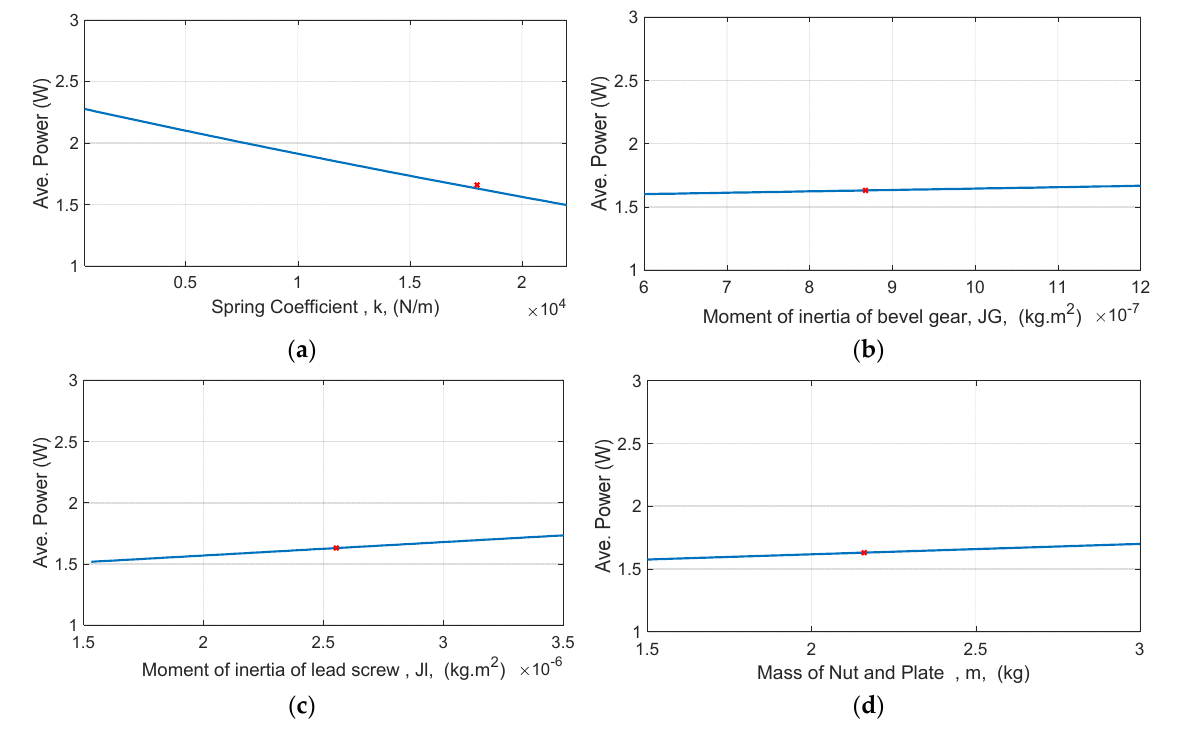
Figure 6. Averaged power when the parameters are varied: ( a ) stiffness coefficient of spring is varied; ( b ) moment of inertia of bevel gear is varied; ( c ) moment of inertia of lead screw is varied; ( d ) mass of nut and plate is varied.